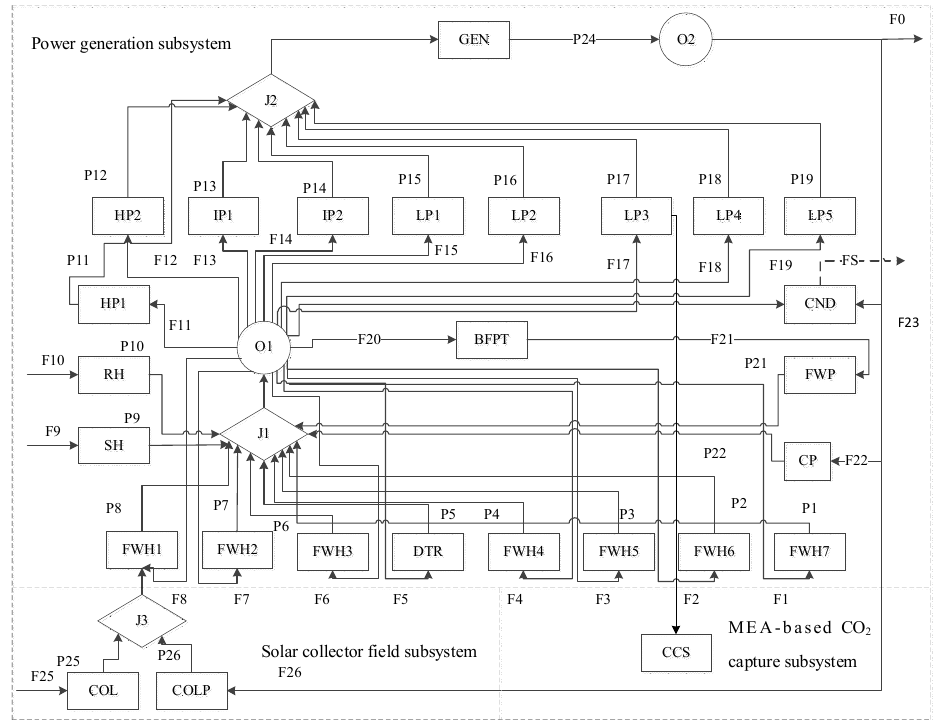
Figure 6. Productive structure of the solar-aided coal-fired power generation with CO 2 capture (SA- PG-CC) system. Energies 2018 , 11 , x FOR PEER REVIEW